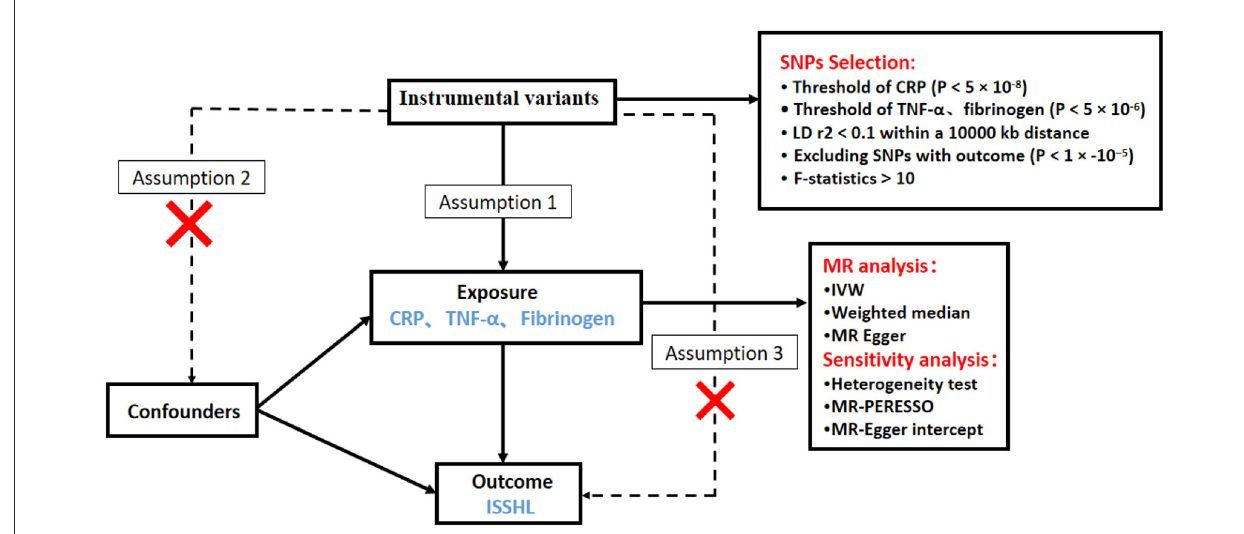
FIGURE1 Schematic diagram of the Mendelian randomization study design process of Inflammatory markers and ISSHL.